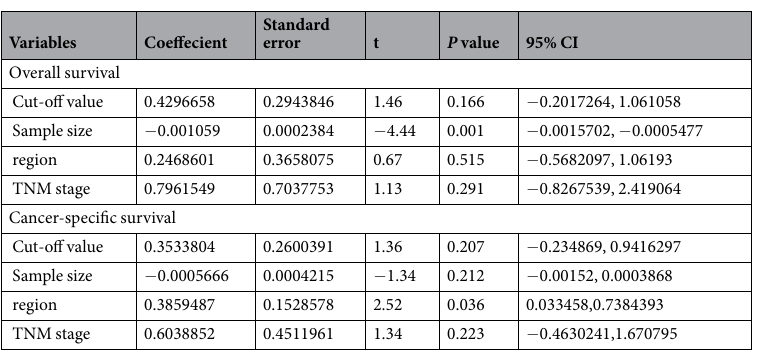
Table 4. Results of meta-regression on OS and CSS